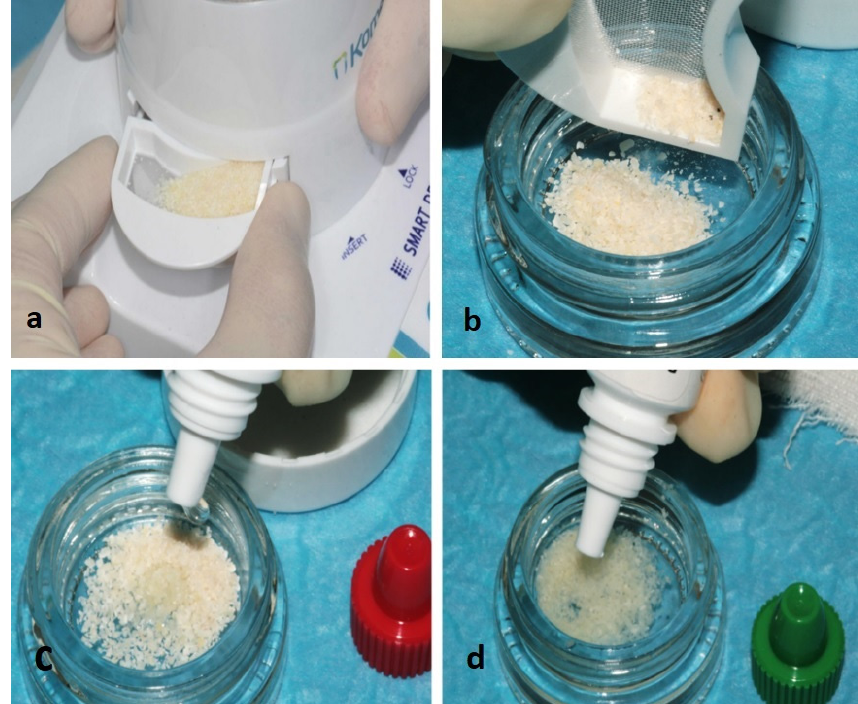
Figure 3. Dentin graft preparation: ( a ) Particulate was obtained with a diameter of 300 to 1200 μ m; ( b ) The particulate was inserted in a sterile dappen, ( c ) rinsed with a 0.5 M NaOH and 20% ethanol solution for 5 min and then ( d ) rinsed two times for 3 min with a phosphate-buffered saline solution. At the experimental sites, the post-extractive socket was filled with the grinded dentin, gently condensed, while control sites were only filled by the blood clot. No barrier membranes were used. In case of total impaction, the flaps were repositioned and stabilized with a 4.0 nylon suture with a primary closure. In case of partial impaction, a transposed flap was adopted to avoid flap tension and obtain a primary closure [28]. Antibiotics were administered for 6 days (1 tablet of amoxicillin 875 mg + clavulanic acid 125 mg every 12 h) associated with local antiseptics (chlorhexidine digluconate 0.20% mouth rinses twice a day for 14 days). Non-steroidal anti-inflammatory analgesics (nimesulide 100 mg) were also prescribed (100 mg every 8 h only in case of pain).